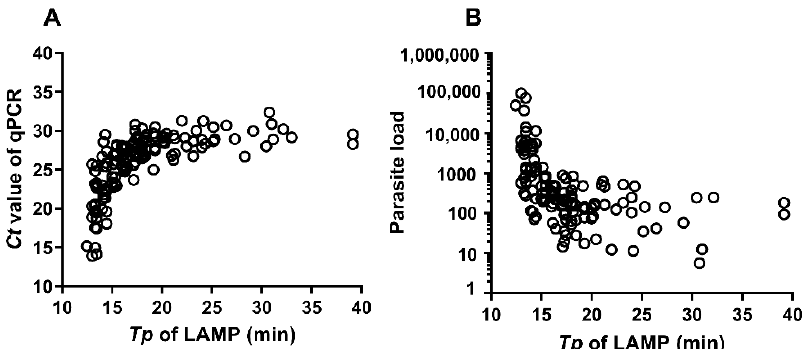
Figure 1. ( A )Correlation (Spearman’s rank) between Loopamp Tp and qPCR Ct values. ( B ) correlation (inverse) between Loopamp Tp and parasite load. Ct: cycle threshold; qPCR: quantitative PCR; Tp: time-to-positivity; LAMP: Loopamp.